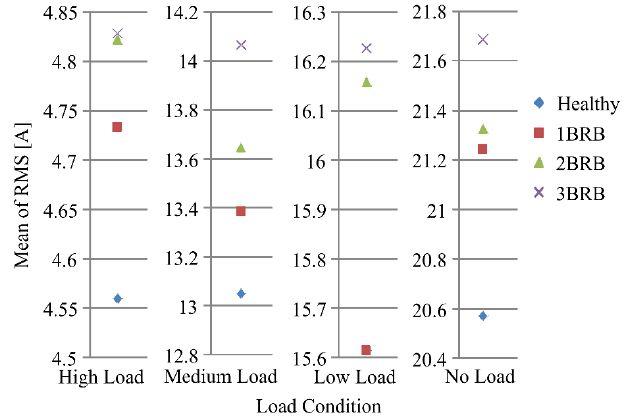
Figure 8. Root ‐ mean ‐ square (RMS) of wavelet packet coefficients (WPC). Figure 8. Root-mean-square (RMS) of wavelet packet coefficients